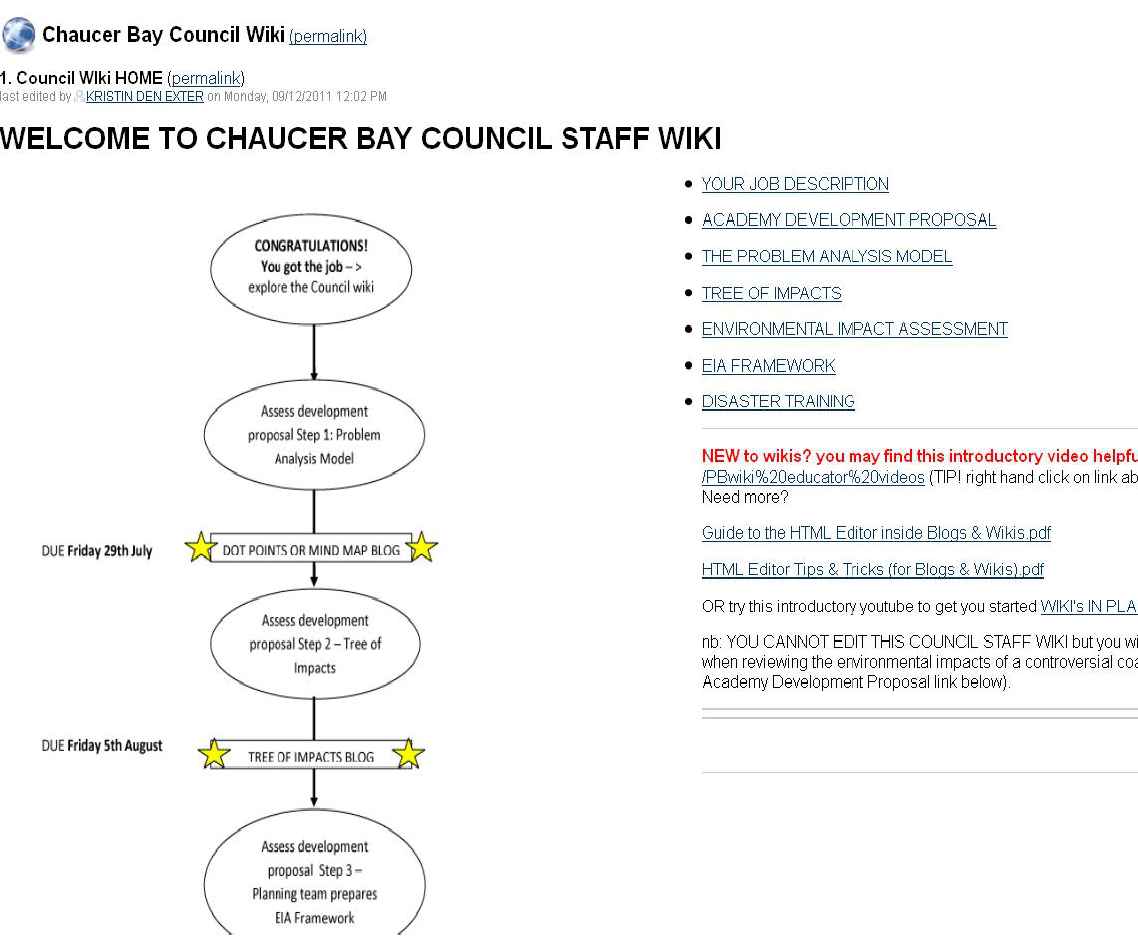
Figure 4. The Home page of the ‗Chaucer Bay Council Wiki‘ wiki used in PCRM to situate students in their scenario-based learning approach, and provide